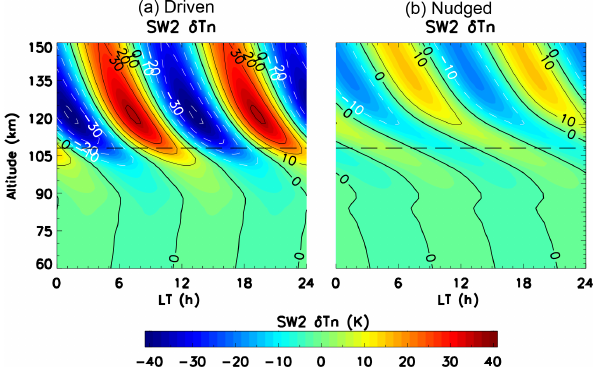
Figure 8. Variation of SW2 temperature tide vs. altitude for ( a ) the GSWM-driven model and ( b ) the NAVGEM-nudged